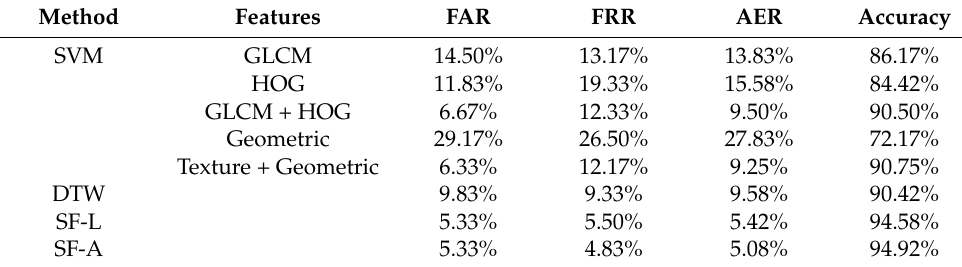
Table 5. The result of five training samples.